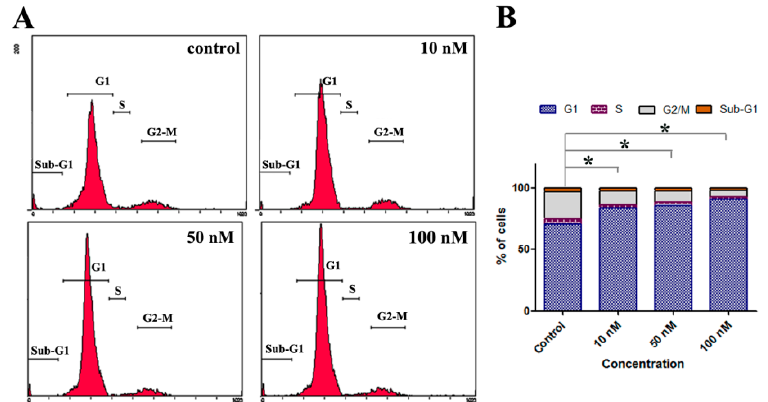
Figure 3. Effect of 31e on cell cycle progression. (A) 97H cells (3 × 10 5 cells/sample) were treated with increasing concentrations of 31e for 24 h, cells were harvested, fixed with 70% ethanol, and stained with propidium iodide (PI). The cellular DNA content was then determined by flow cytometry analysis. (B) Quantitative analysis of the percentage of cells in each cell cycle phase was analyzed by EXPO32 ADC analysis software. The data were presented as the mean ± SEM *P < 0.05, significantly different compared with the control by t test.